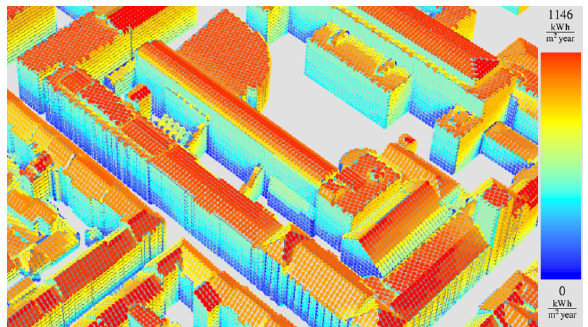
Figure 9. Point cloud generated from CityGML building models in the process of a solar potential simulation (Willenborg et al.,